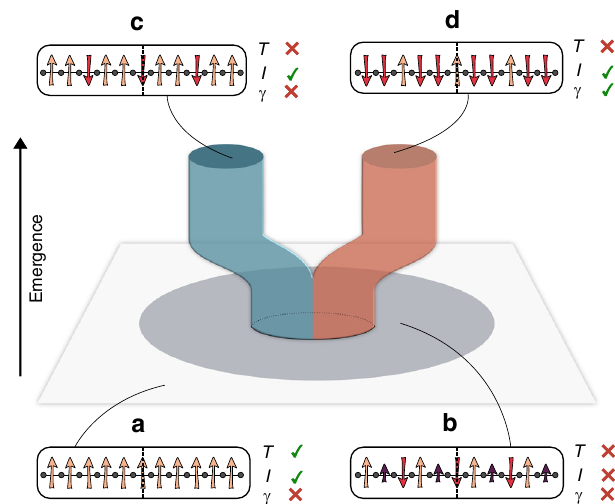
Fig. 1 Emergent symmetry protection: we represent qualitatively a ground- state manifold, where different quantum phases are characterized by their symmetry and topological properties, and use spin patterns on the bonds of a 1D lattice to exemplify the different con fi gurations. ( a ) Ground state satisfying both translation ( T ) and inversion ( I ) symmetry, but lacking any nonzero topological invariant ( γ ). The spontaneous breaking of translation symmetry results in a phase with a three-site unit cell, represented in ( b ) with different arrows accounting for the three possible magnetizations, which may not respect the inversion symmetry, lacking a nonzero topological invariant. Remarkably, such inversion symmetry can emerge from all the possible con fi gurations constrained by the SSB pattern, leading to the low-energy sectors depicted in ( c , d ). Note that these two phases are not only distinguished by the SSB pattern, but also, and more importantly, by topology. Accordingly, whereas ( c ) is topologically trivial, ( d ) presents both a local order parameter and a nonzero topological invariant, and thus corresponds to an intertwined topological phase where the protecting symmetry